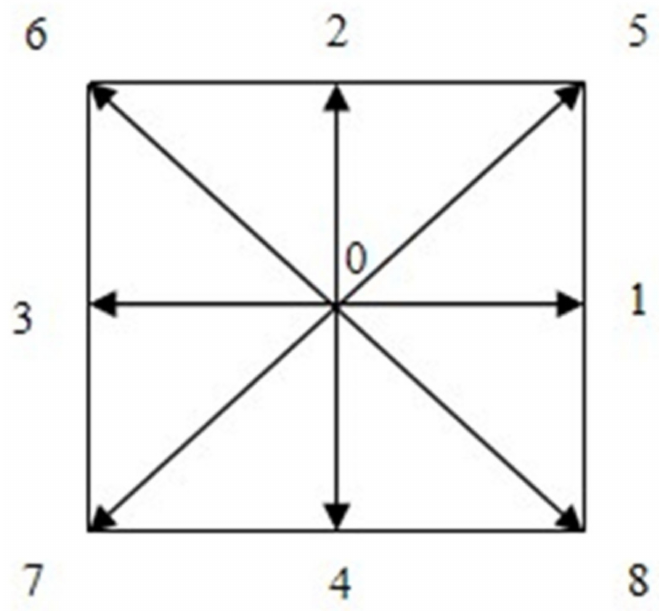
Figure 1. Schematic of the D2Q9